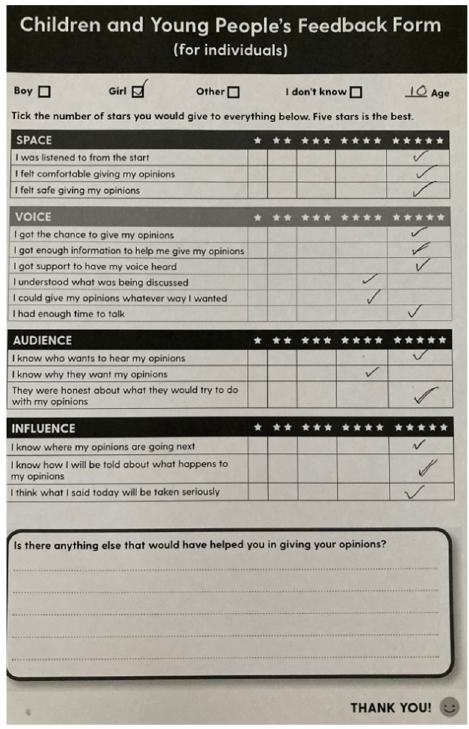
Figure 1. Evaluation form completed by a Child Advisor.